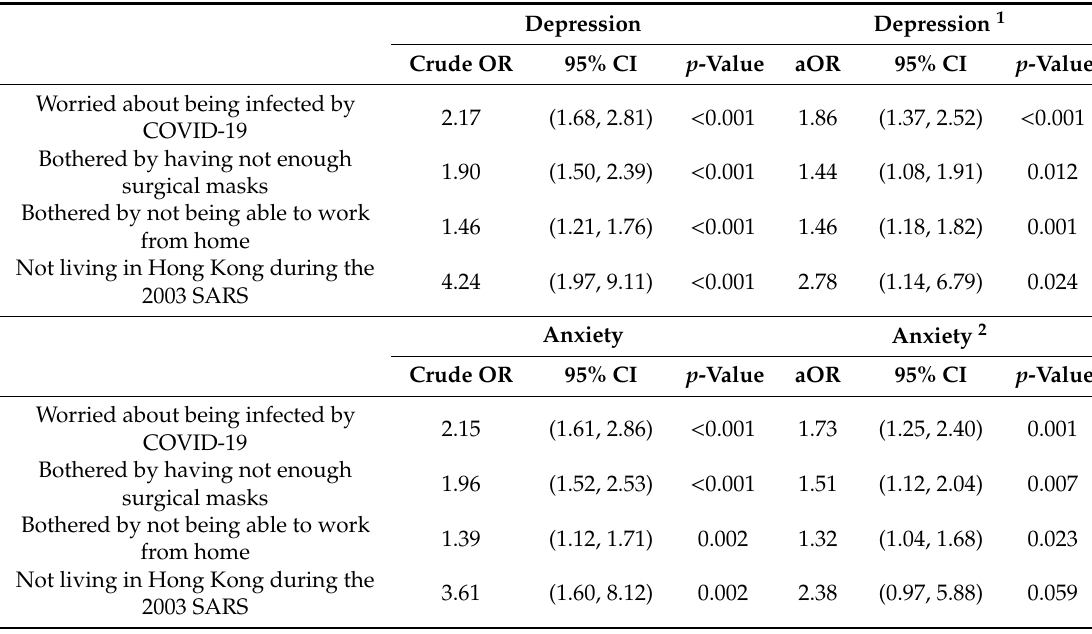
Table 2. Logistic regression to explore factors associated with poor mental